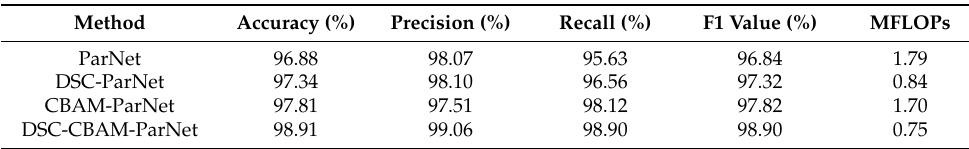
Table 2. Recognition effect of ablation